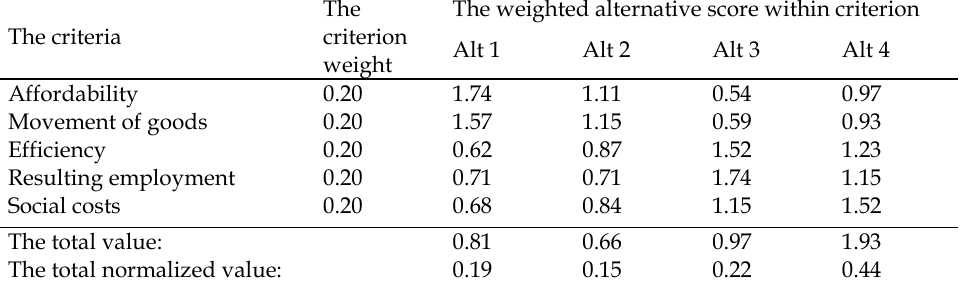
Table 3. Normalised score of the alternatives assessed: economic sustainability